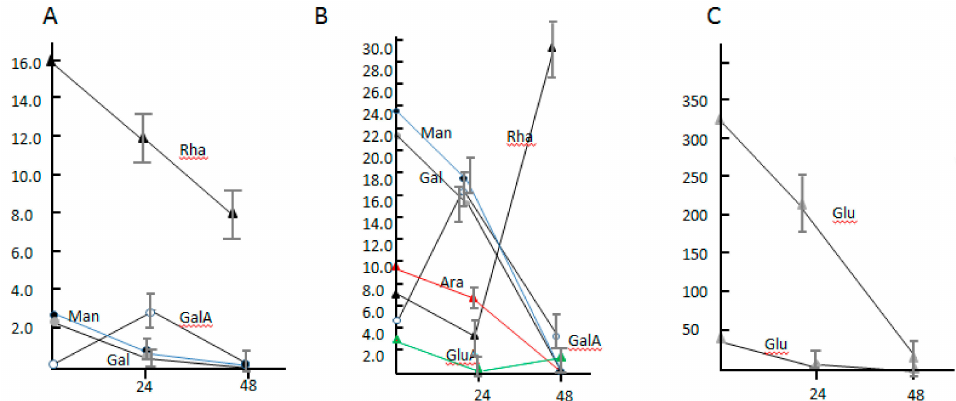
Figure 5. The monosaccharide component shift in Minimal Salt Medium (MSM) + vegetable stalks. ( A ) monosaccharide component shift in 1% MSM + vegetable stalks except glucose; ( B ) monosaccharide component shift in 5% MSM + vegetable stalks except glucose; ( C ) the change of glucose concentration in 1% or 5% MSM + vegetable